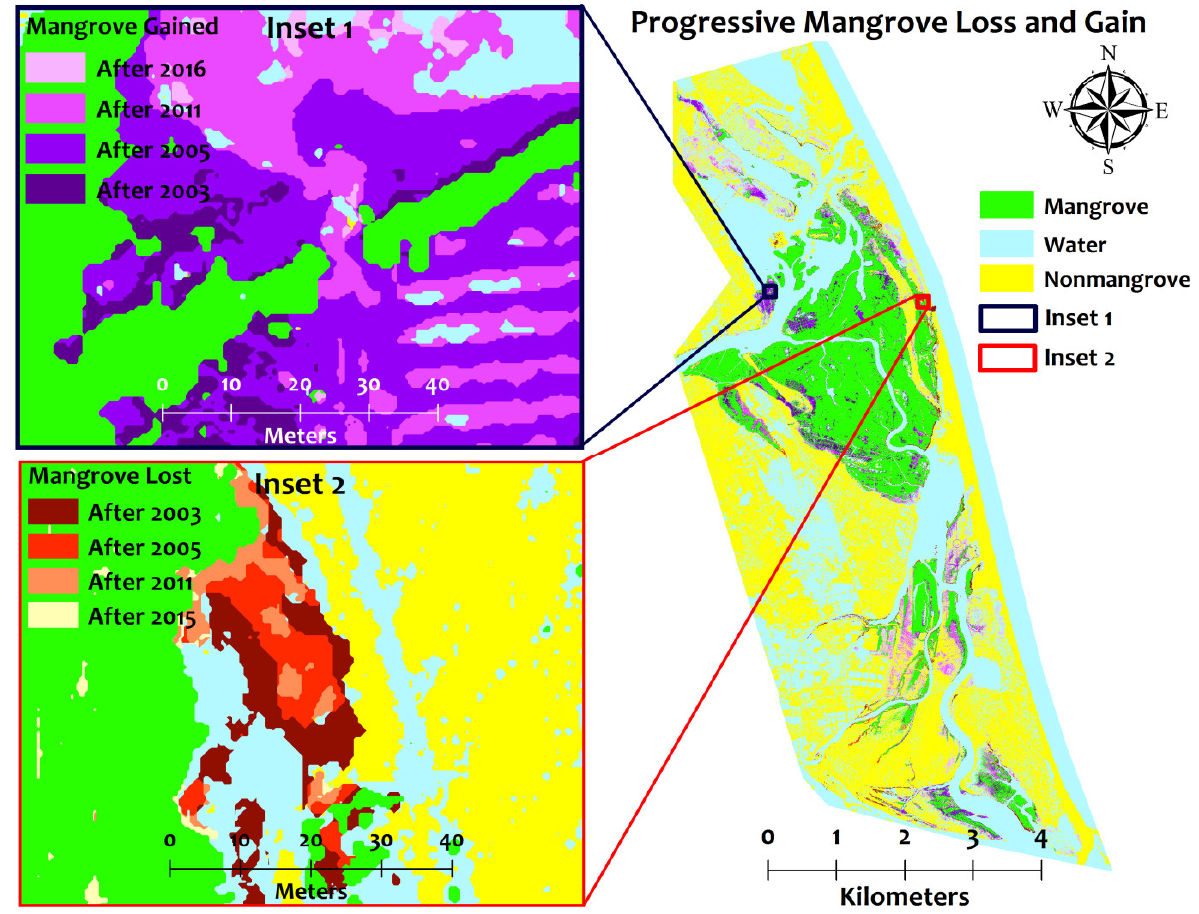
Figure 13. Mangrove gains and losses as captured by VHSR images at different time intervals in